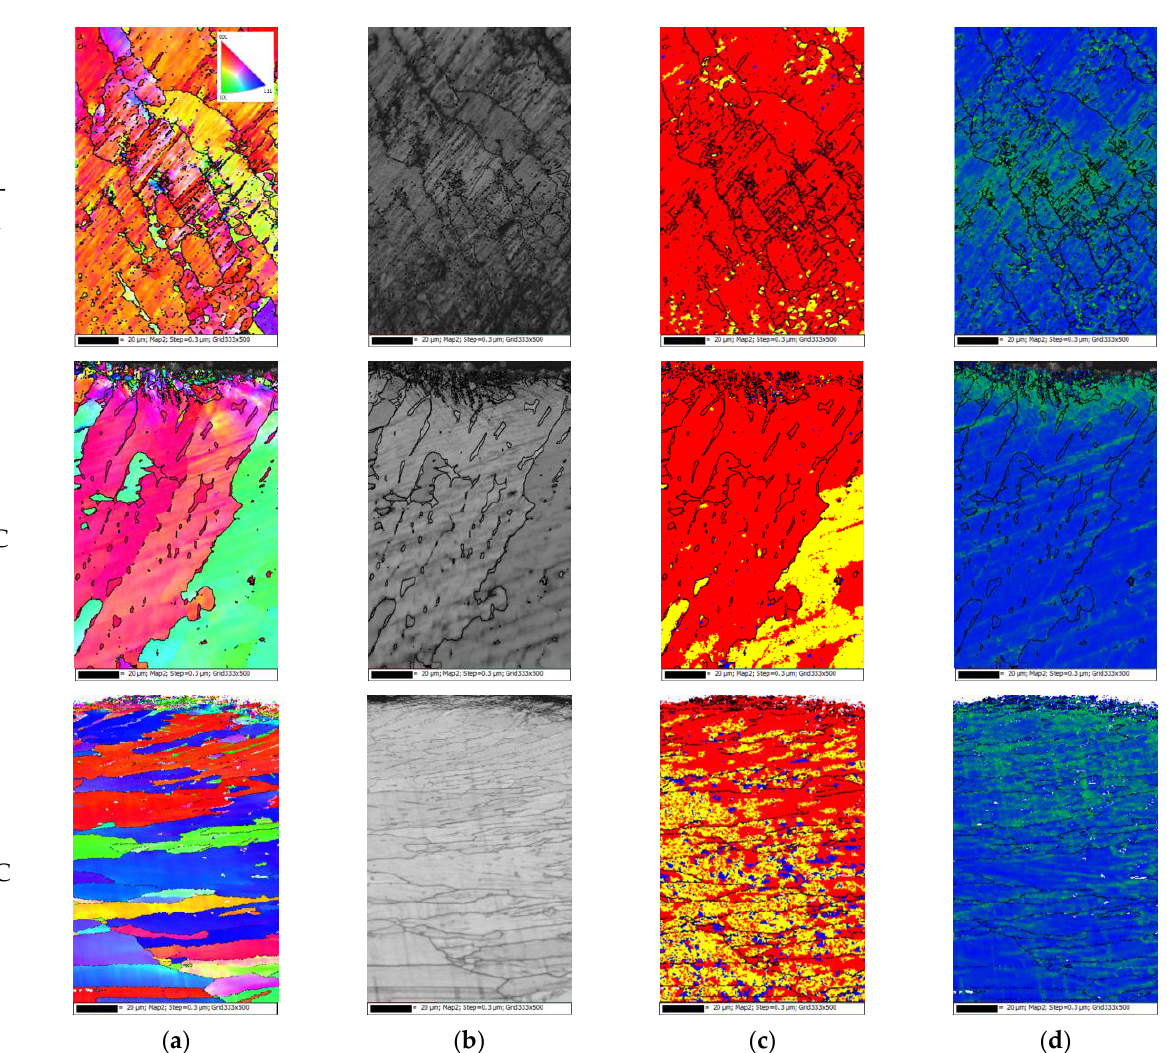
Figure 12. EBSD results of 304L weldment after laser peening (EBSD: step size 0.3 μm, depth ~150 μm); ( a ) IPF coloring, ( b ) band contrast, ( c ) recrystallized fraction, and ( d ) dislocation density.